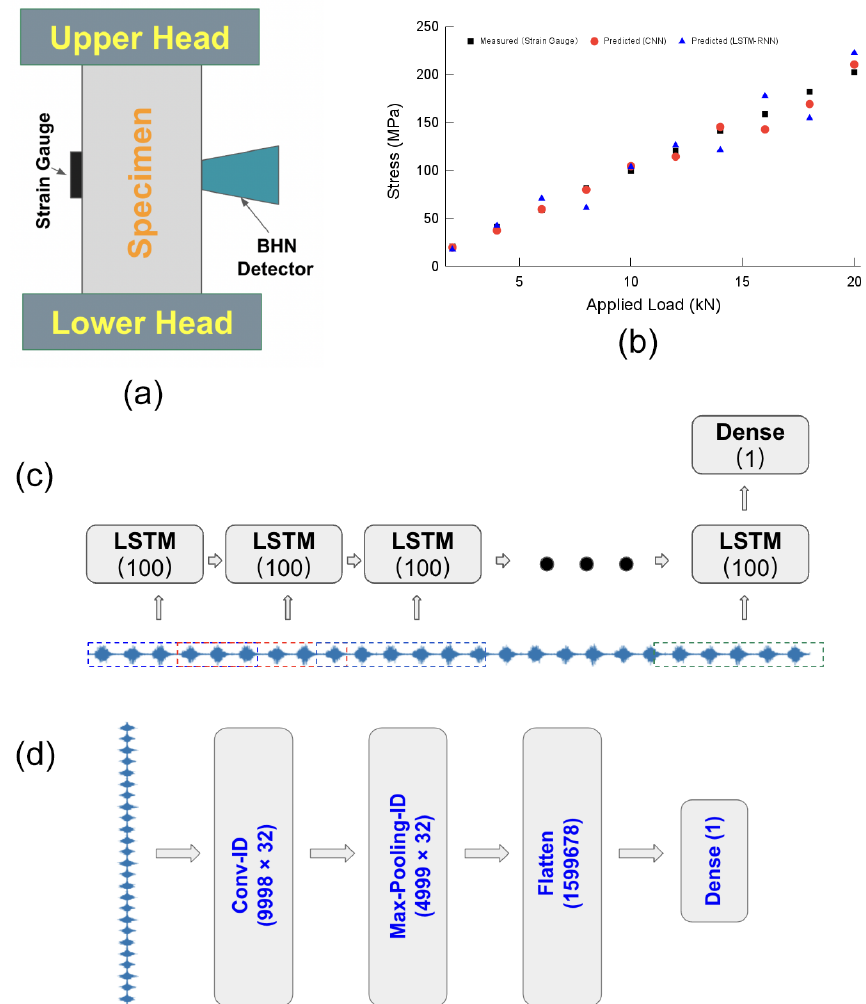
Figure 1. (a) A sketch of the experimental set-up; (b) a sample set of measured stresses under different loads; and the neural network structure of the (c) LSTM-RNN and (d) CNN